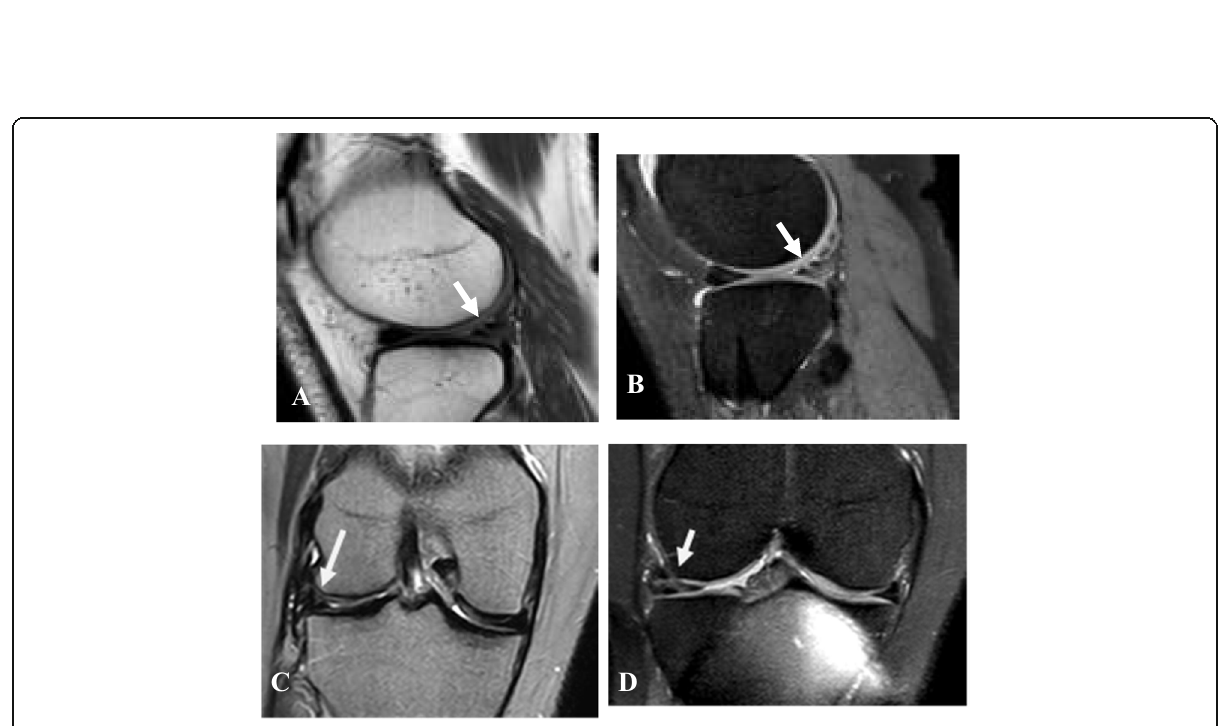
Fig. 3 A 29-year-old male patient presented by acute RT knee joint pain after trauma. a , b Sagittal Standard 2D PDWI and 3D MPR VISTA images show complex branching tear in PHLM (white arrows). c , d Coronal standard 2D PD and 3D MPR VISTA images again show complex branching tear in PHLM (long white arrows), clearly outlined in the VISTA